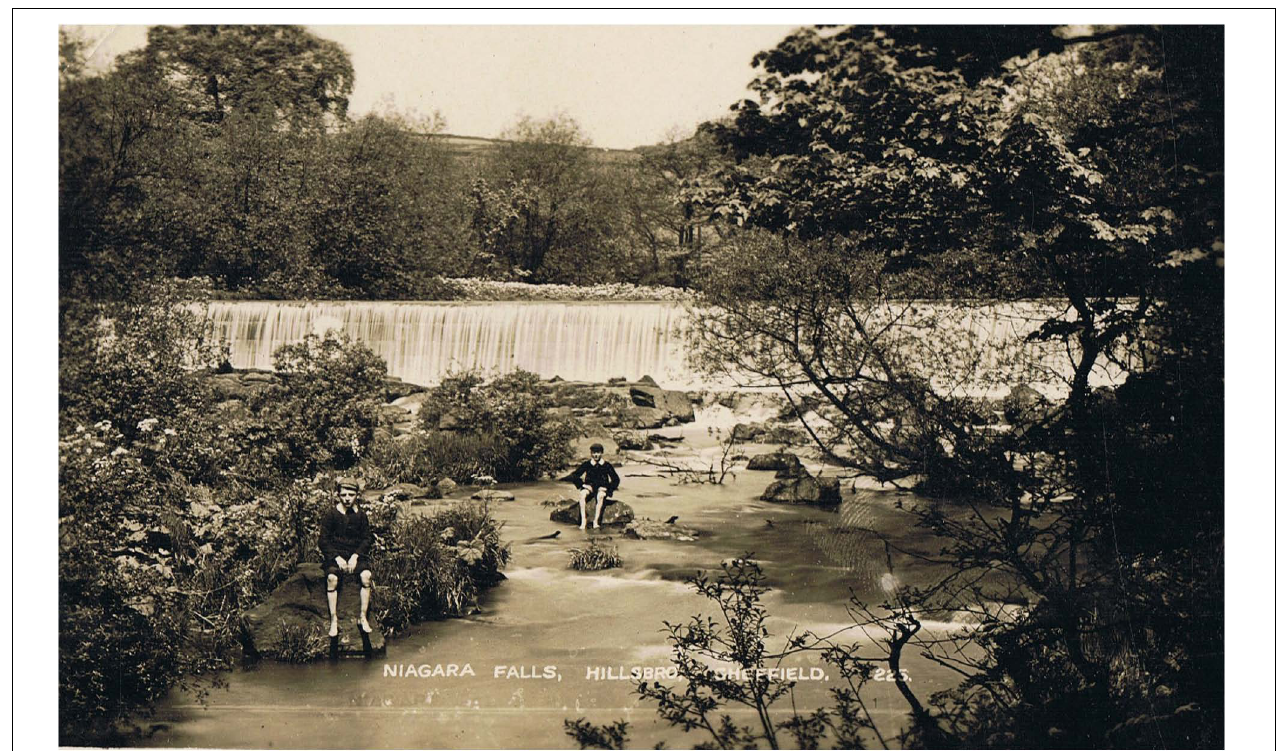
FIGURE 4 | Niagara Weir at Wadsley Bridge in the 1930s with a still rural landscape in the background but the butterbur